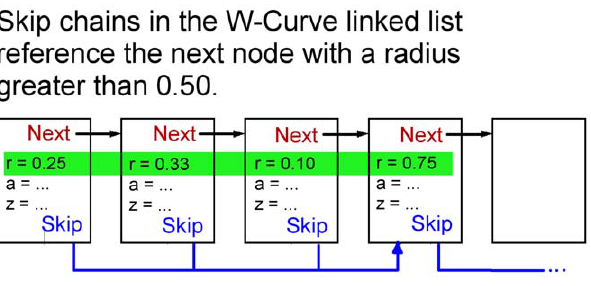
Figure 9. Linked List and Skip Chain. Points on the W-curve are stored as nodes in a linked list, using either Cylindrical (shown) or Cartesian notation. The skip chain for each node references the next node with a radius greater than 0.50, giving direct access to nodes used in re-aligning the curves after a gap or indel. doi:10.1371/journal.pone.0010829.g009 PLoS ONE |